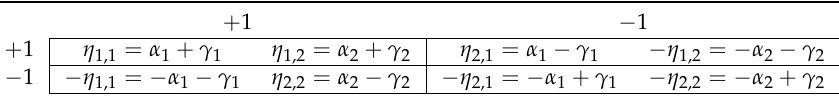
Table 5. The G N Nash